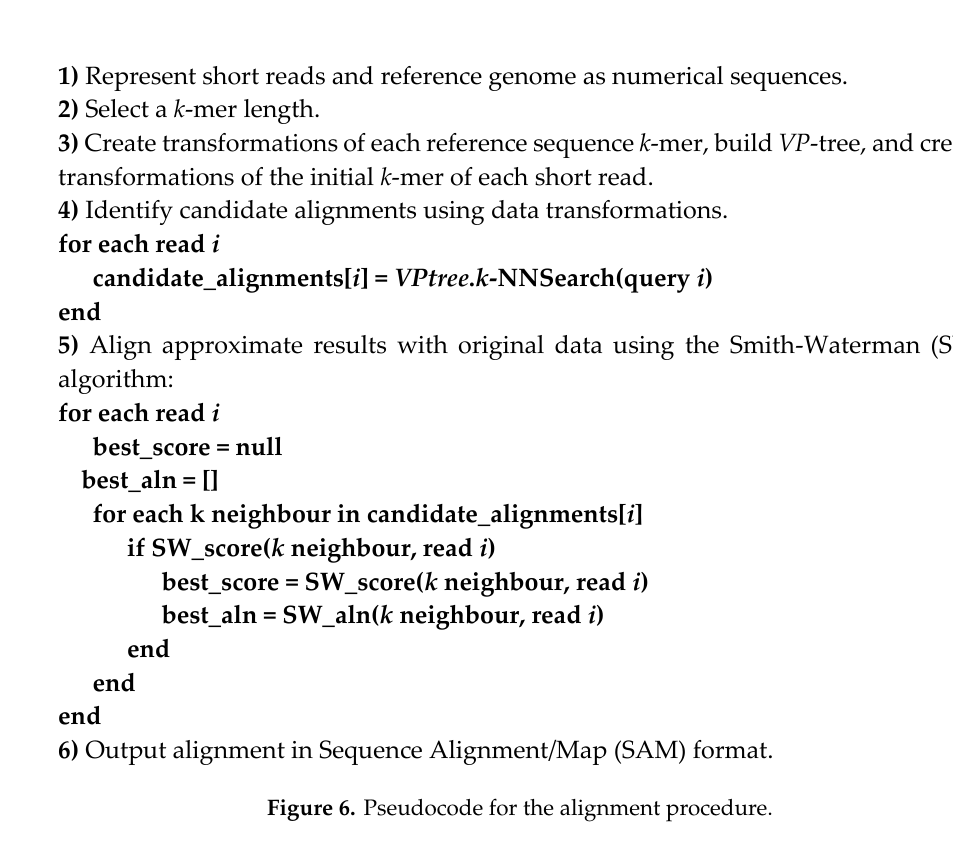
Figure 6. Pseudocode for the alignment procedure.